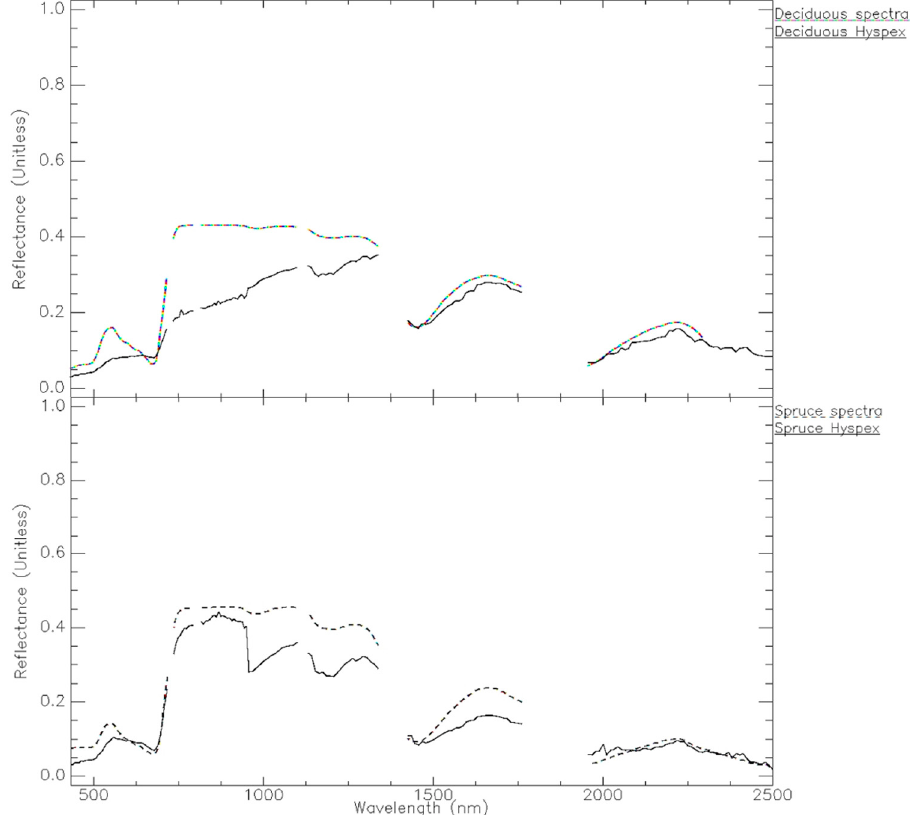
Figure 8. Comparison of HySpex spectra (solid line) and spectral library data (dashed line) for deciduous (upper panel) and spruce (lower panel) categories. Atmospheric water vapor and noisy bands were removed from the spectral library data for a good visual comparison with the HySpex spectra. Deciduous spectral library data were only available up to 2300 nm.